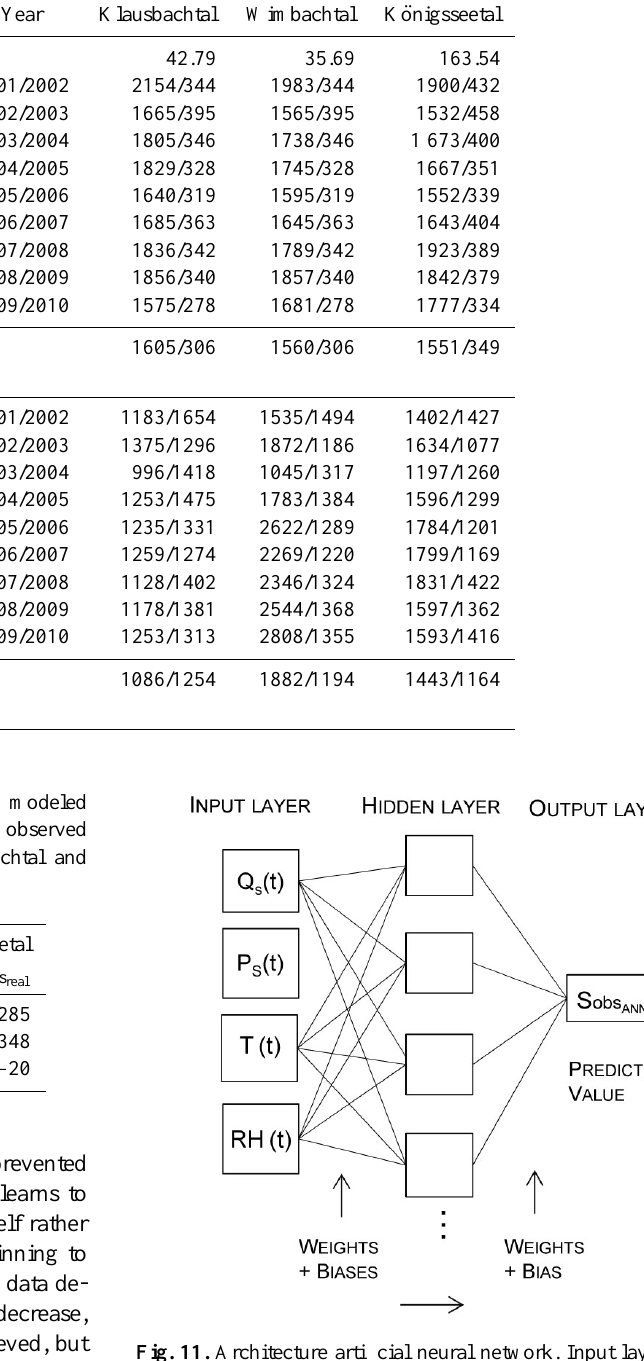
Fig. 11. Architecture artificial neural network. Input layer, hidden layer and output layer. The inputs Q S (t) (snow melt and/or rain), snow precipitation P S (t) , temperature T (t) , relative humidity RH( t ) (t) give the observed water storage S obs ANN